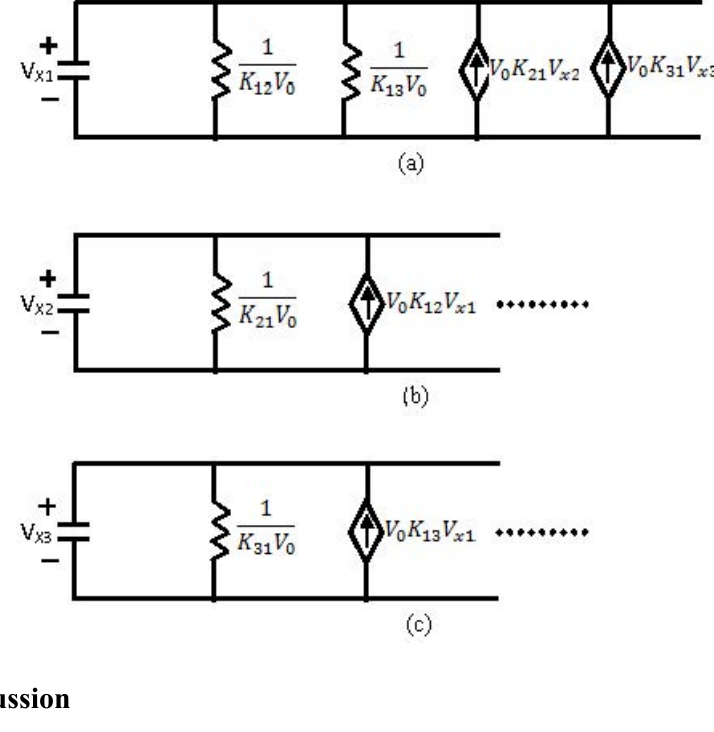
. ( b ) and 1 and X , respectively. 2 3